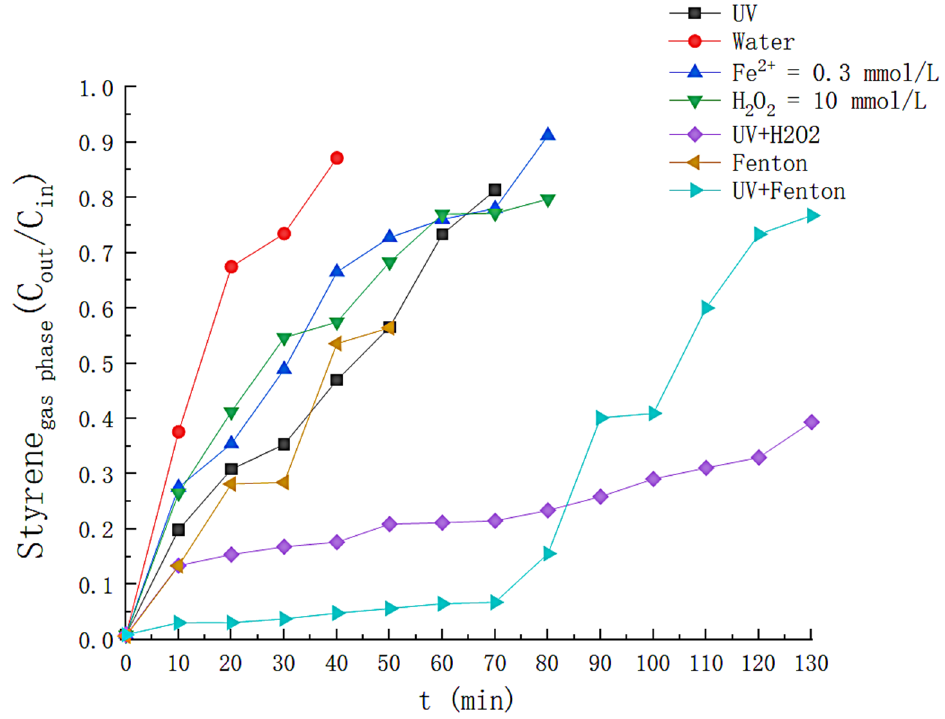
Figure 2. Experimental comparison of different reaction systems.